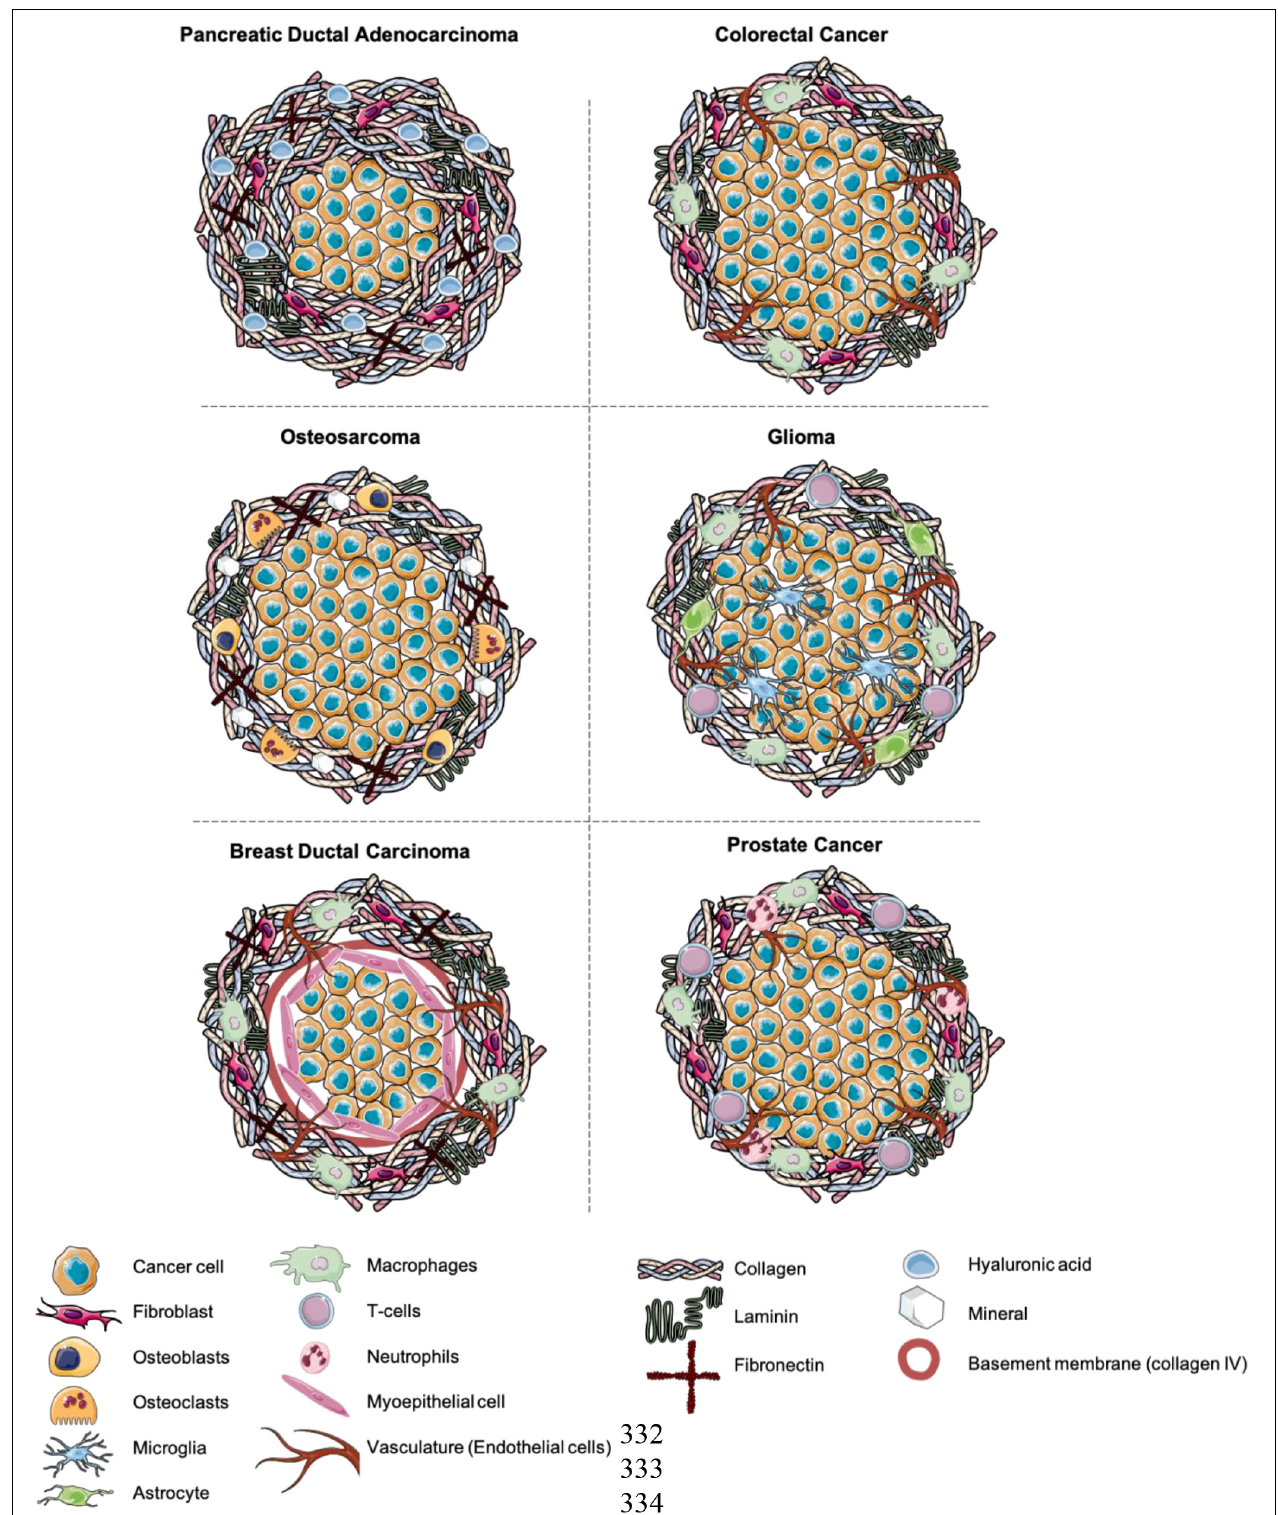
FIGURE 2 | Suggestions for the future modeling of 3D cancer models. Composed of a central cancer mass and stromal compartment containing stromal cell populations and ECM components.